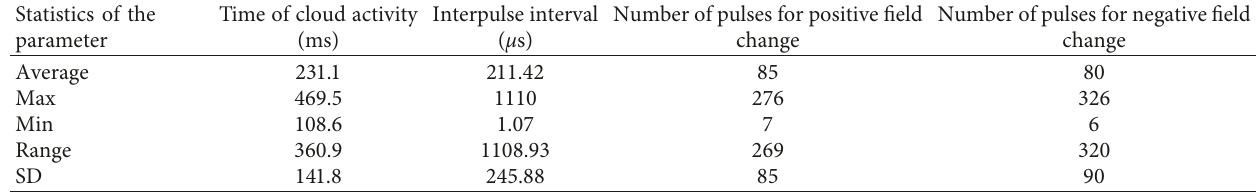
Table 4: A summary of statistics for the flashes with negative initial pulse polarity.